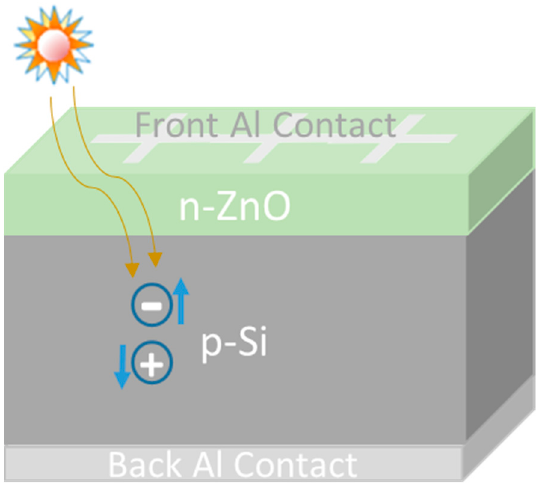
Figure 1. Schematic of the n-ZnO/p-Si single heterojunction solar cell structure.